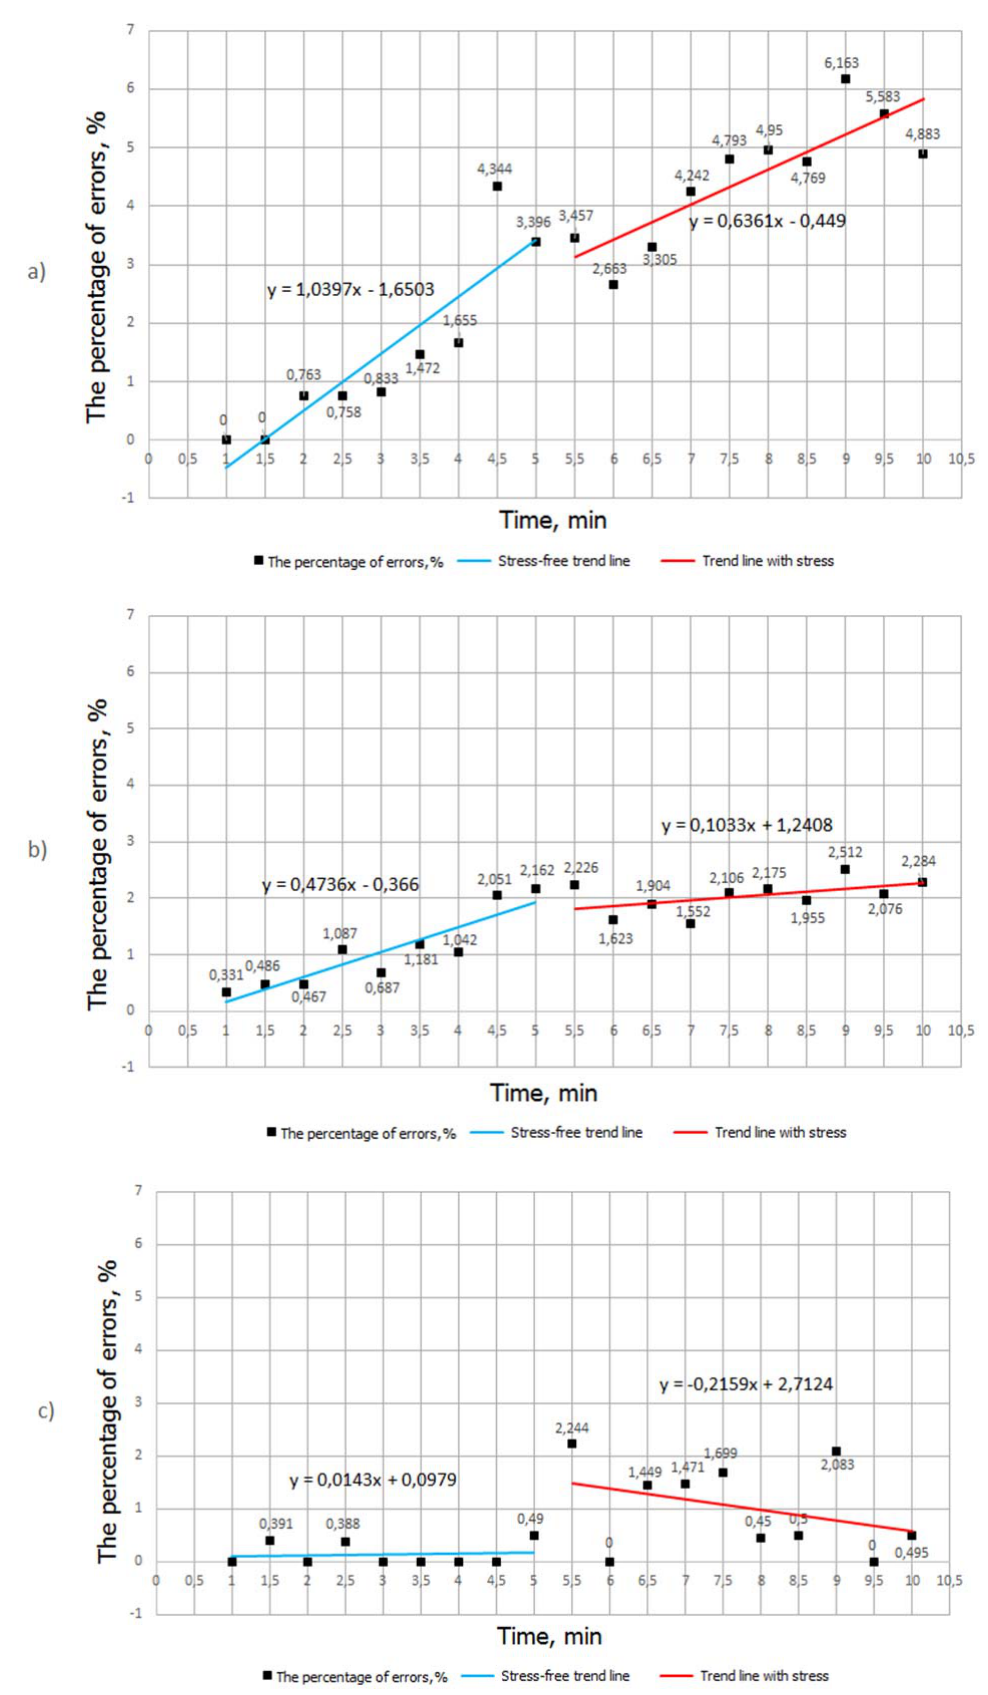
Figure 2. Change of averaged parameters K and V medium (b) and high (c) stress tolerance